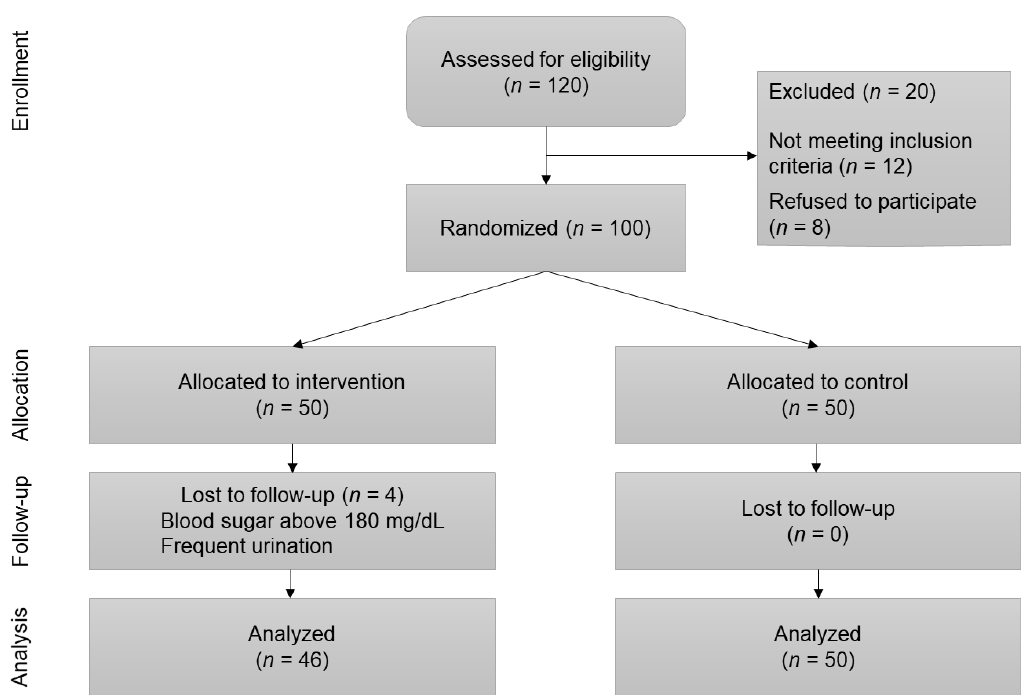
Figure 1. Flow chart of the study.